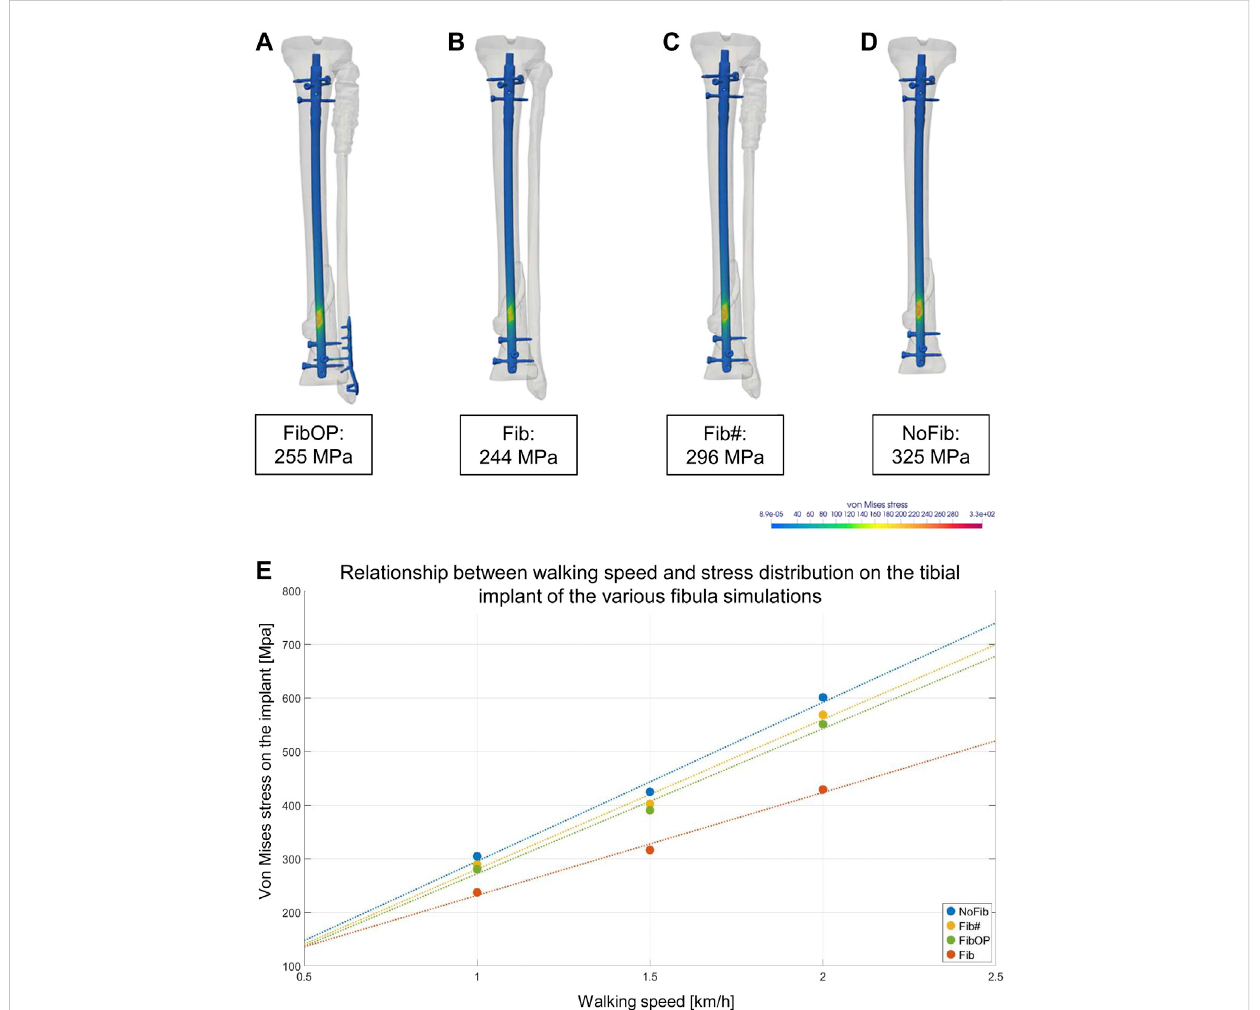
FIGURE 6 ResultsofthedifferentFEsimulationsofthe fi bulaanditsimpactonthestressmaximaontheintramedullarynail.A-DshowthevonMisesequivalent stressforthemomentofmaximumaxialloadingduringapatient ’ sstepforwardathis fi rstphysicaltherapysession. (A) :Simulationofplateosteosynthesis of the distal fi bula (FibOP) corresponding with the real treatment. (B) : Simulation of unfractured fi bula (Fib). Note the only slight difference of the strain maximum toFibOP. (C) :Simulationofproximally anddistallyfractured fi bula(Fib#)withoutsurgical intervention.NotetheincreaseofthevonMises stress on the implant. (D) : Simulation of excluded fi bula (NoFib) with further increase on the intramedullary nail in the tibia, demonstrating the impact of the fi bula and its stability on the von Mises stress within the tibia. (E) : The various fi bula simulations and their impact on the tibial implant in relation to the walking speed of the